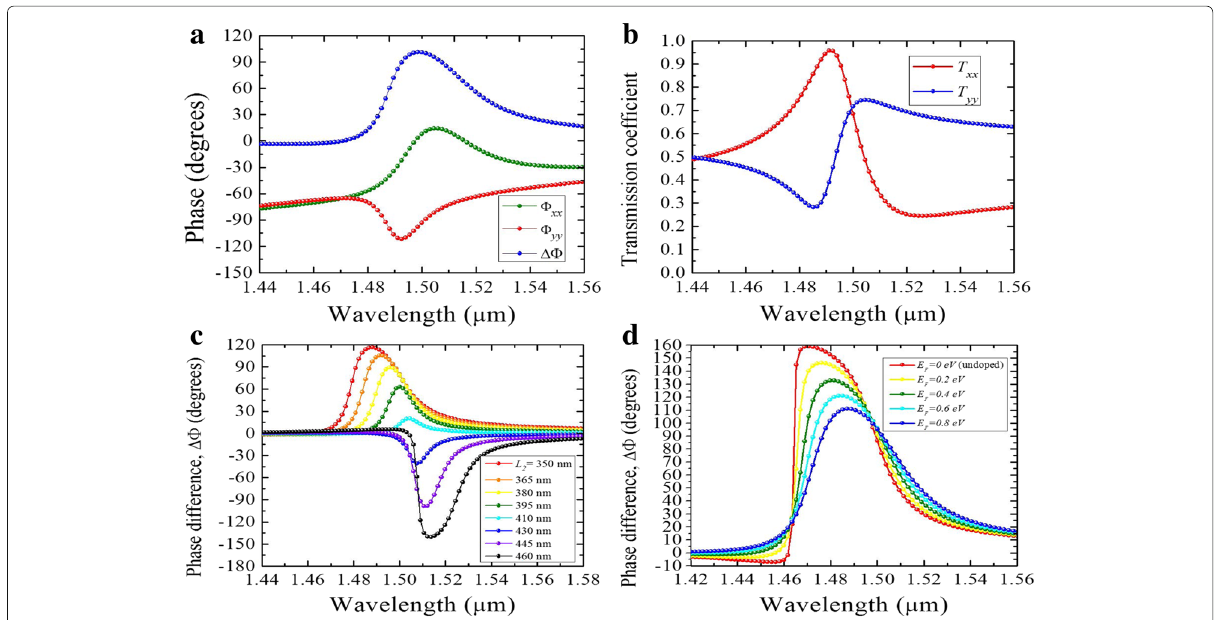
Fig. 4 a Phase components and retardation of an all-dielectric/graphene metasurface and b the corresponding transmission coefficients T xx and T yy . Phase retardation plotted as a function of wavelength for L 1 = 440 nm, L 2 = 370 nm, and W = 60 nm, for c varying Fermi energy and d varying L 2 from 350 to 450